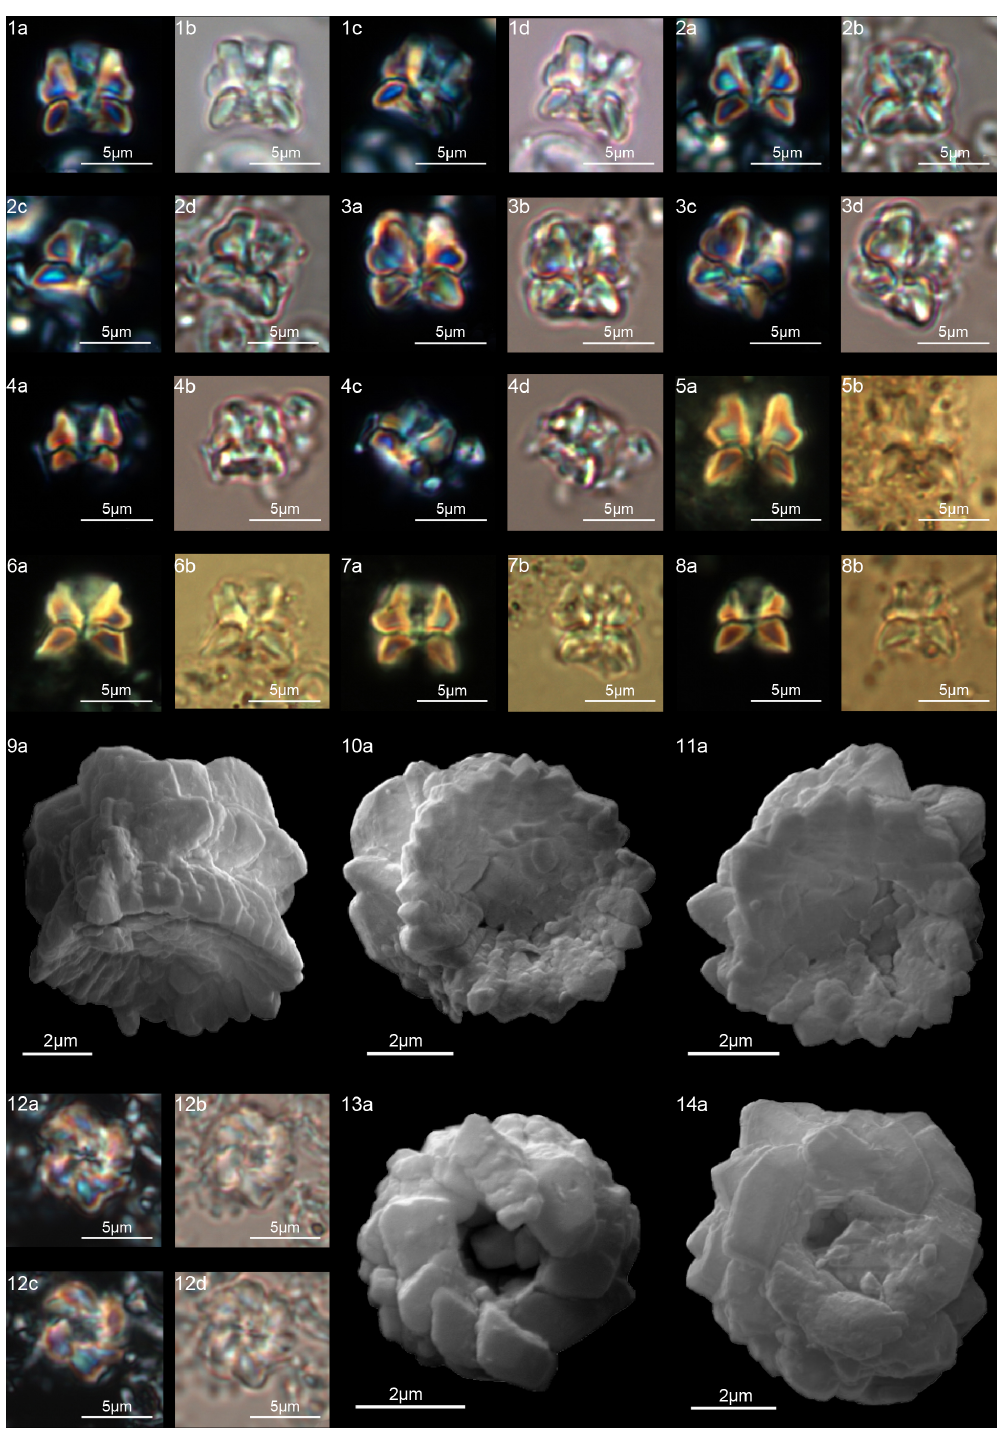
Figure 12. Diantholitha magnolia . (1) Sample: 1262C 11-2, 56–57. (1a, c) XPL, (1b, d) PPL. (2) Sample: 1262C 11-2, 56–57. (2a, c) XPL, (2b, d) PPL. (3) Sample: 1209C 14-1, 116–117. (3a, c) XPL, (3b, d) PPL. (4) Sample: 1209C 14-1, 116–117. (4a, c) XPL, (4b, d) PPL. (5) Sample: Qreiya + 8.3. (5a) XPL, (5b) PPL. (6) Sample: Qreiya + 8.6. (6a) XPL, (6b) PPL. (7) Sample: Qreiya + 8.3. (7a) XPL, (7b) PPL. (8) Sample: Qreiya + 8.3. (8a) XPL, (8b) PPL. (9) Sample: 1262C 11-2, 56–57. (9a) SEM lateral and proximal view. (10) Sample: 1262C 11-2, 56–57. (10a) SEM proximal view. (11) Sample: 1262C 11-2, 56–57. (11a) SEM, proximal view. (12) Sample: 1262C 11-2, 56–57. LM, distal view. (12a, c) XPL, (12b, d) PPL. (13) Sample: 1262C 10-6, 23–24. (13a) SEM, distal view. (14) Sample: 1262C 11-2, 56–57. (14a) SEM, distal view. See Table S1 for sample